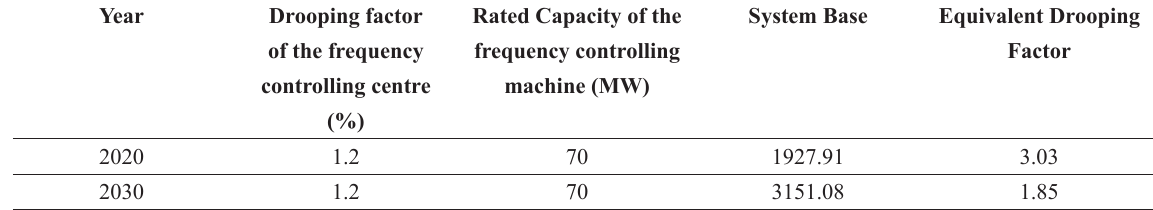
Table 3: Calculation of equivalent drooping factors Year Drooping factor of the frequency